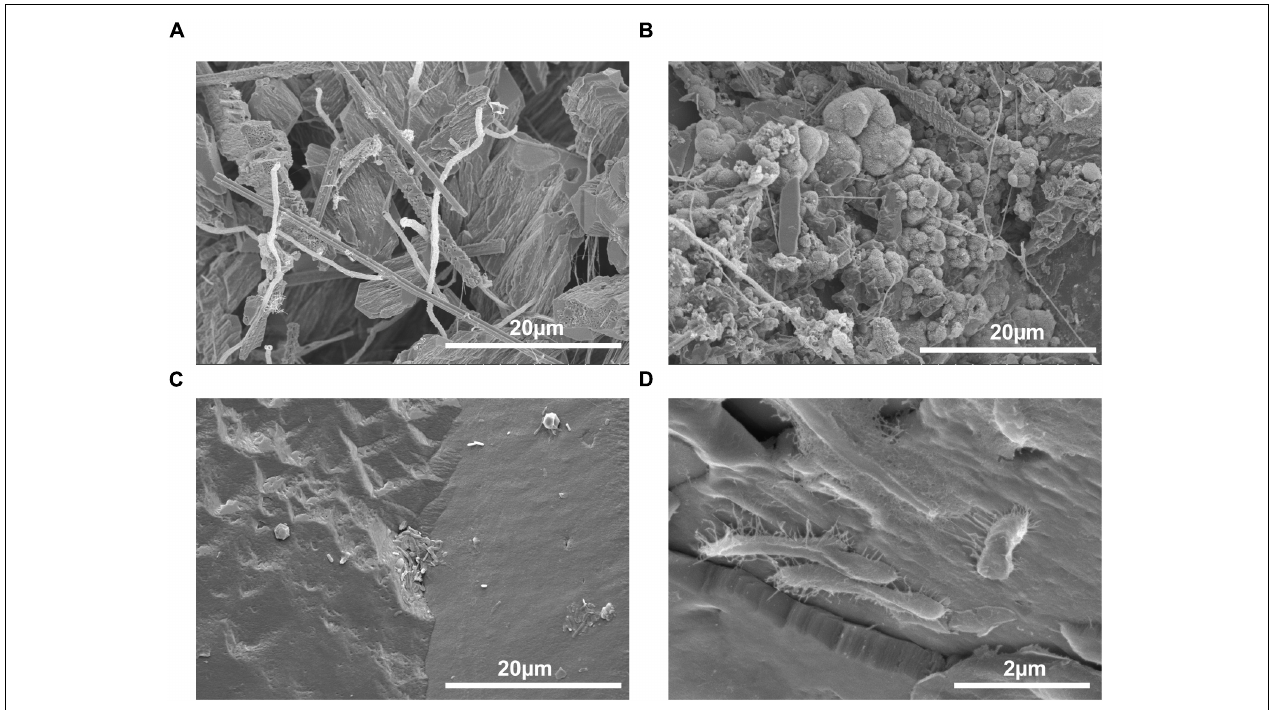
FIGURE 2 | Scanning electron micrographs of speleothems with an abundance and variety of microorganisms present. (A) Inside of a popcorn speleothem sample (1000 × ), (B) outside of a popcorn speleothem sample (2500 × ), (C) internal base of a soda straw speleothem (2500 × ), and (D) exterior surface of a soda straw speleothem (1500 ×